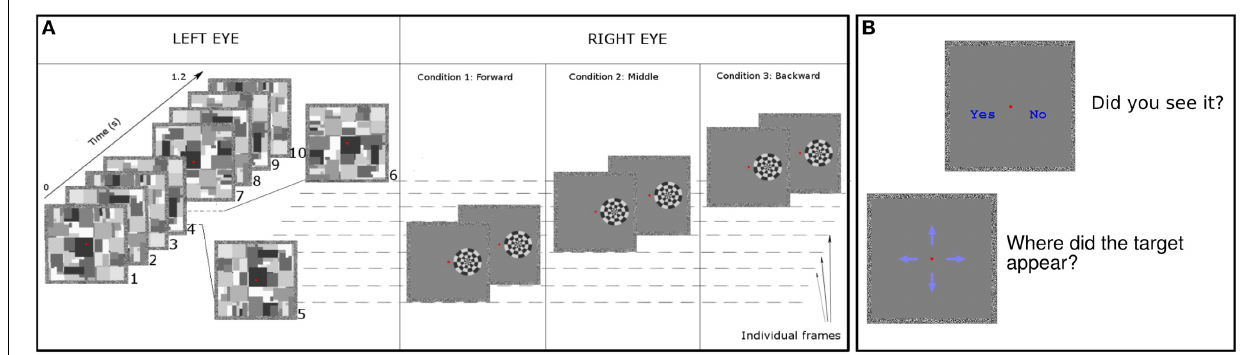
at an equal temporal distance between the previous and subsequent Mondrian. Backward condition : we displayed targets for two frames before displaying the Mondrian. In all conditions the Mondrian’s luminance polarity changed from the first frame to the second frame (see Materials and Methods Section). (B) On each trial, after the stimulus presentation we asked subjects to (1) report the location of the target on the screen and (2) to indicate whether they had perceived the target among the Mondrian